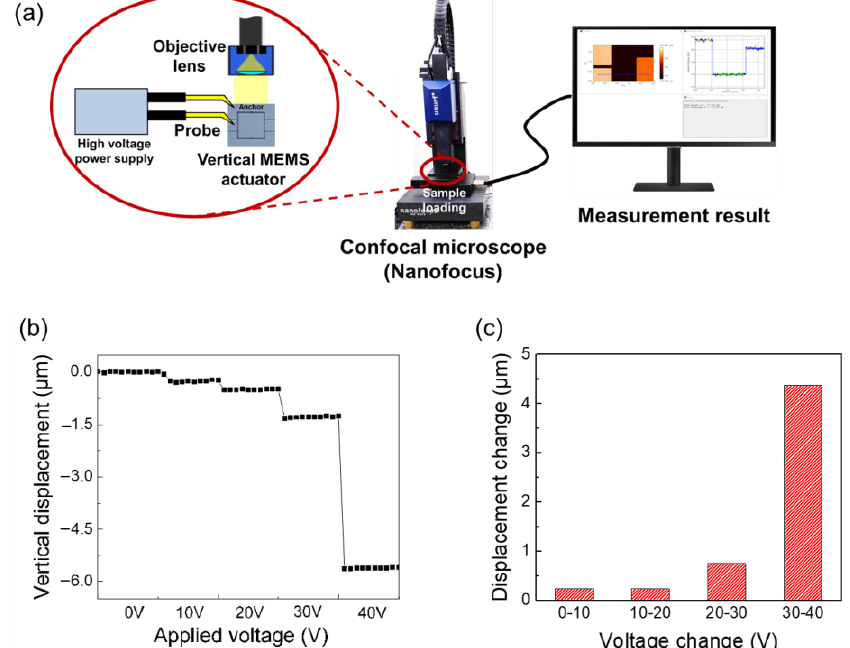
Figure 7. ( a ) Measurement set up schematic, ( b ) measured vertical displacement according to the applied voltage, ( c ) displacement change with voltage change of 10 V intervals.